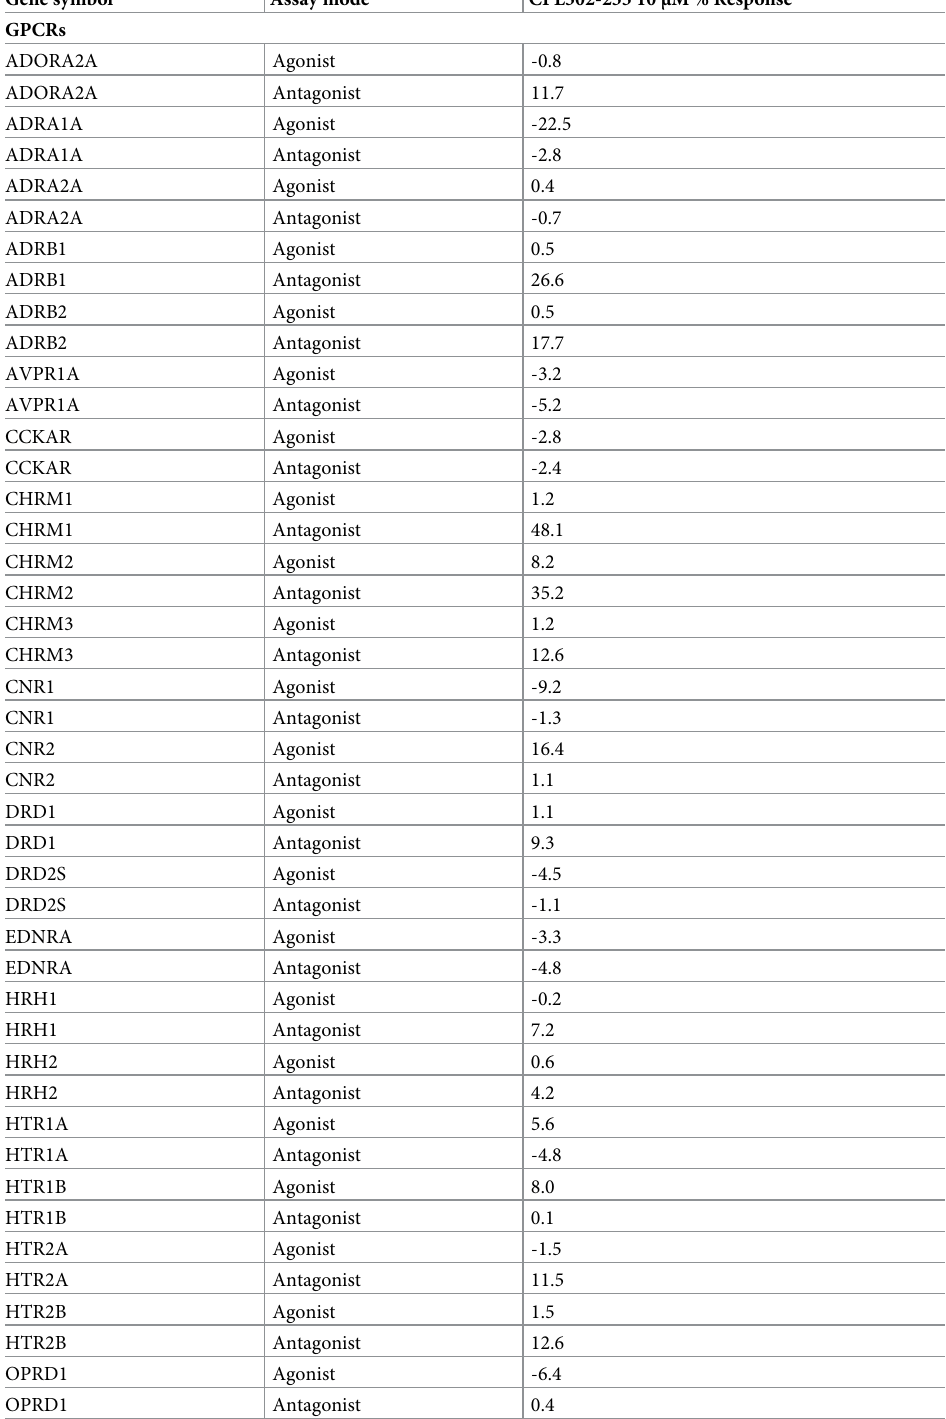
Table 3. CPL302-253 selectivity in SafetyScan44 panel. Genetically modified reporter cell lines were treated with CPL302-253 at 10 μ M. G Protein-Coupled Receptors (GPCR), transporters, ion channels, nuclear receptors, kinases and non-kinase enzymes activity was measured in corresponding cell model. The CPL302-253 influence on measured parameter is indicated as % of response in control